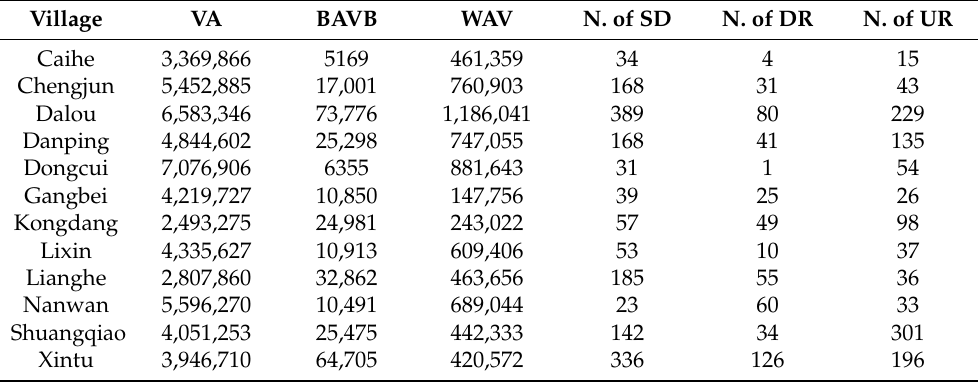
Table 2. Variable data of the selected 12